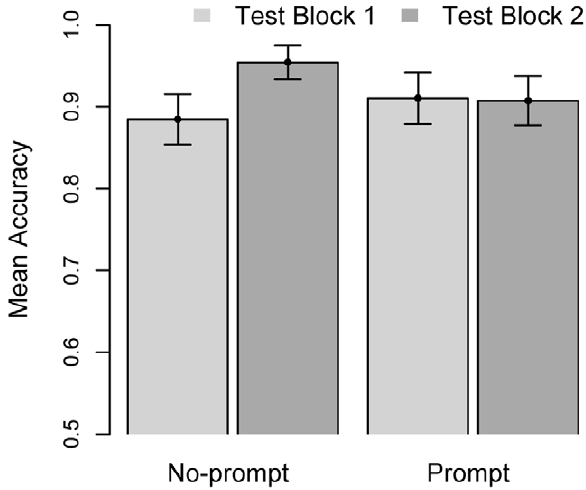
Figure 2. Mean accuracy in No-prompt and Prompt conditions, depicted separately for test blocks 1 and 2. Error bars